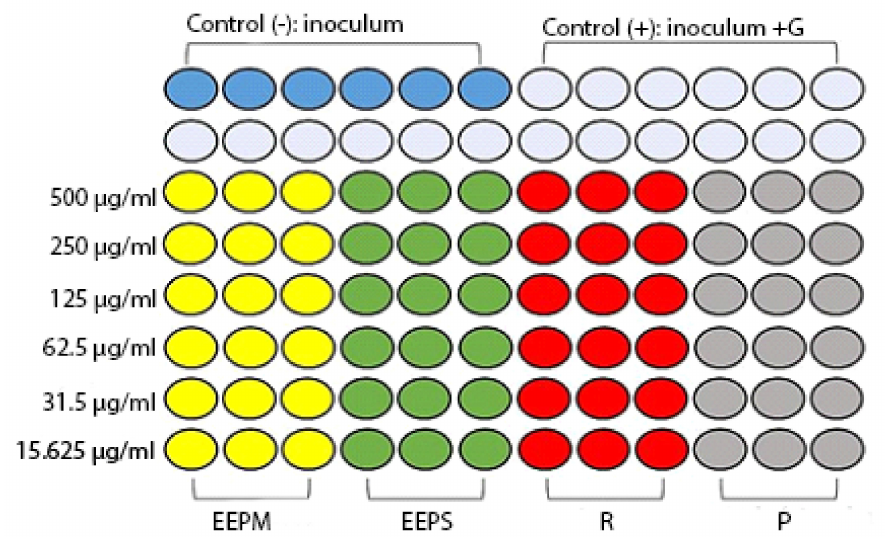
Figure 12. Arrangement of samples and inoculum solutions in control plates (96 wells) for the biological tests on the microorganisms mentioned